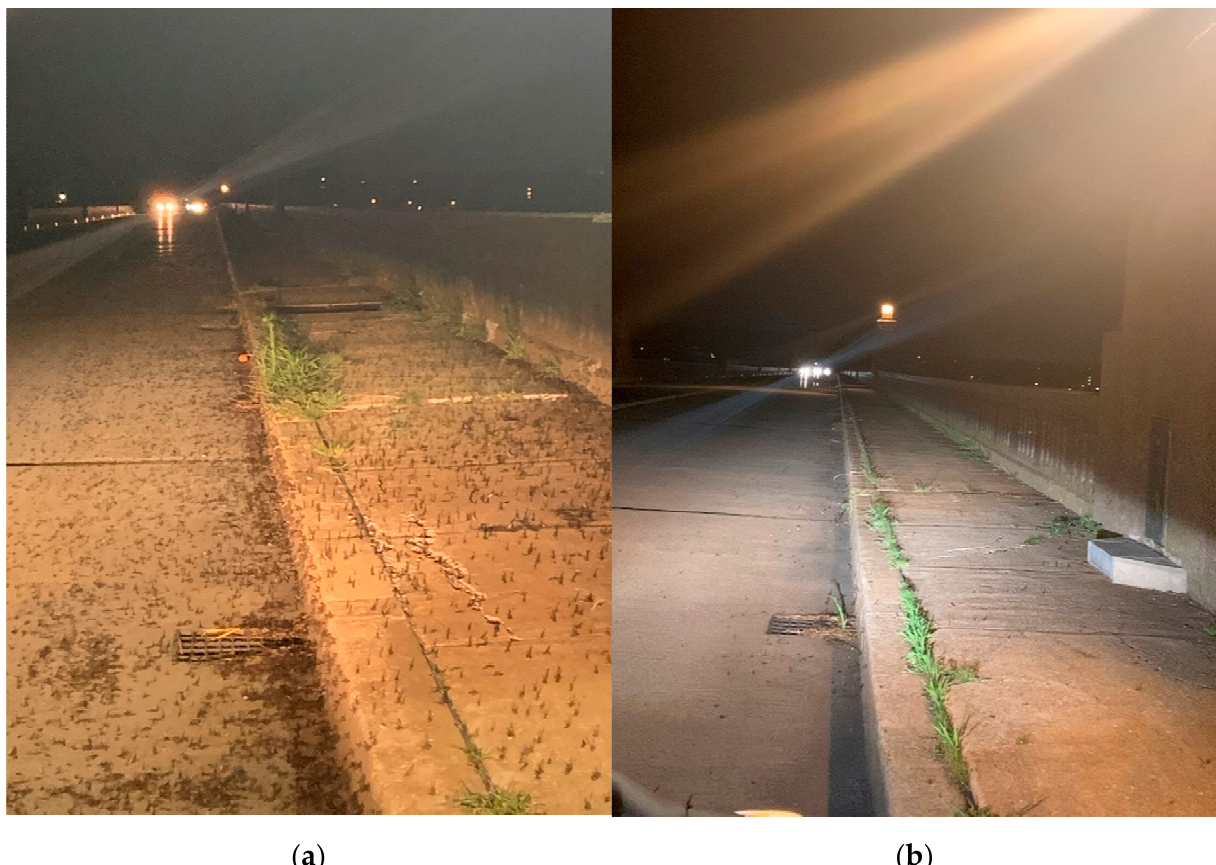
Figure 6. Photos of roadway and sidewalk near the base of the light fixtures on the piers of the Veterans Memorial Bridge: ( a ) at Span 12 (4800 K); ( b ) at Span 20 (2200 K) taken within minutes of each other during trial CW7. Visual observations suggested that more mayflies were attracted to the higher CCT light source (left image), despite no significant difference in statistical analysis between the trials. It should be noted that due to the car headlamps, the image on the right appears to be higher CCT, but the roadway luminaire in that image does indeed have the 2200 K light source.